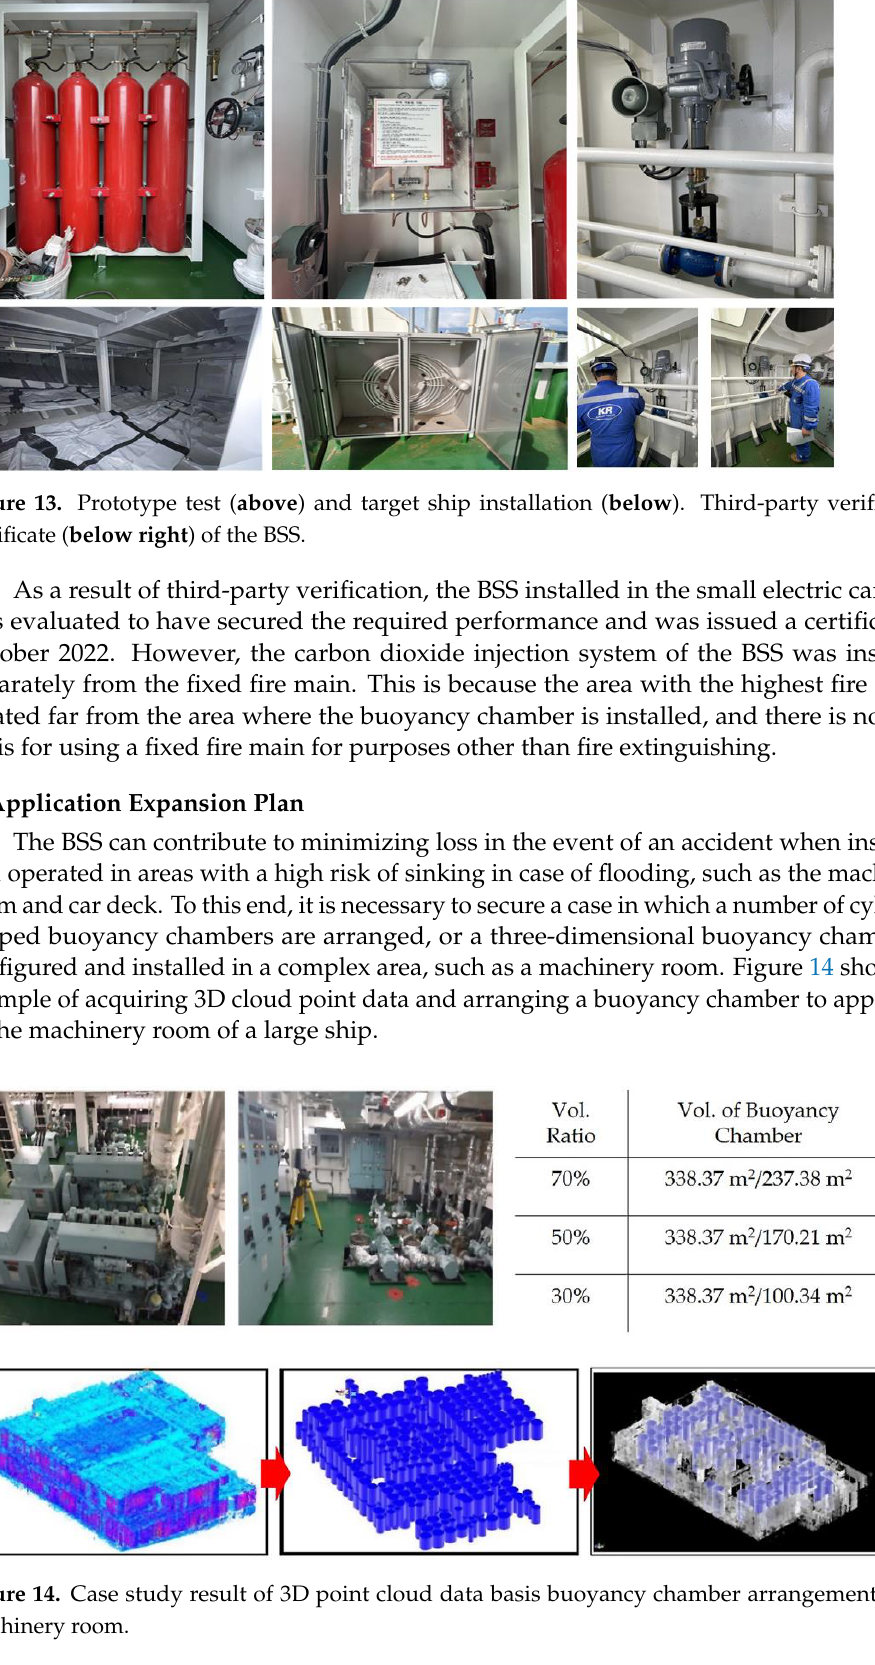
Figure 15. BSS to be equipped; 2600 GT class K-GTB appearance and specifications. Figure 16 shows the general arrangement of the K-GTB. The BSS is designed with consideration of the installation of the machinery room and the alternative fuel demon- stration area near the midship, where the MW class battery, fuel cell, and carbon-free fuel mixed combustion engine systems are installed.